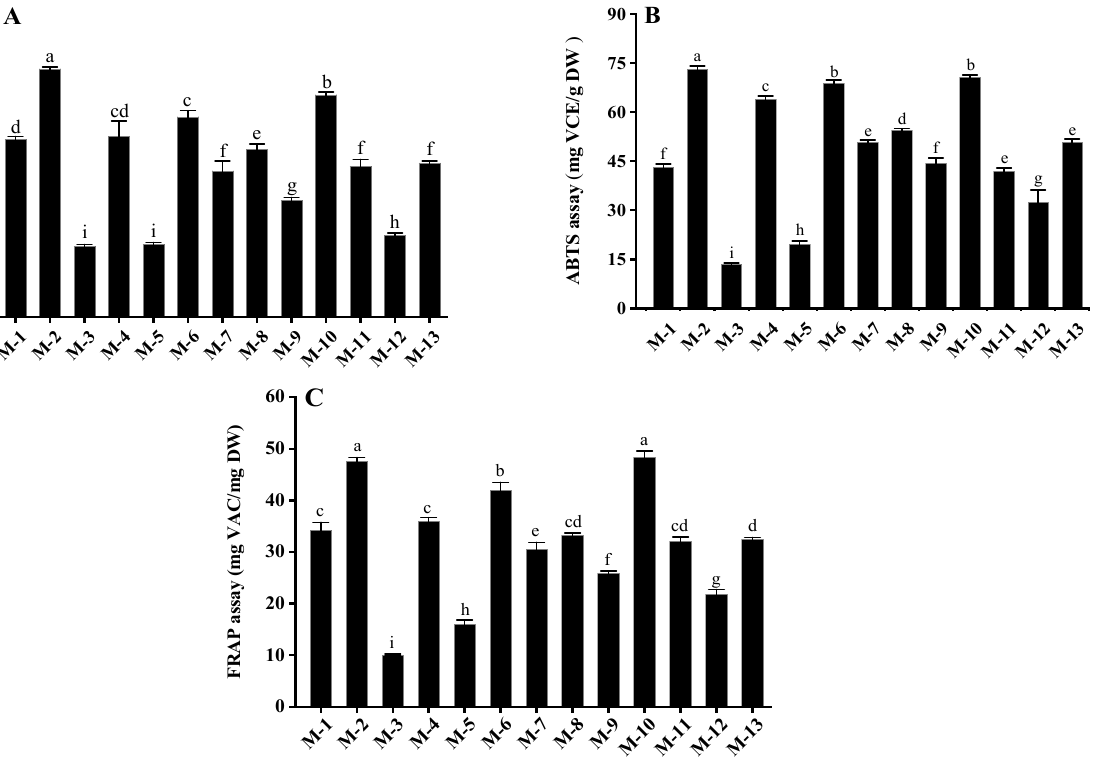
Figure 1. Antioxidant activities of different mulberry samples measured by ( A ) DPPH, ( B ) ABTS and ( C ) FRAP assays. Values in the different letters are significant differences ( p < 0.05). M-1, Yichuanhong; M-2, Qiong46; M-3, Guosang8632; M-4, Yuebanguo; M-5, Yueshen28; M-6, Yueshen74; M-7, D10; M-8, Jinqiang63; M-9, Yunguo1; M-10, Heizhenzhu; M-11, Xuanguo1; M-12, Guiyou12; M-13, Shansang. Table 4. Correlations between total phenolic contents, total flavonoid contents, total anthocyanin contents and antioxidant activities.